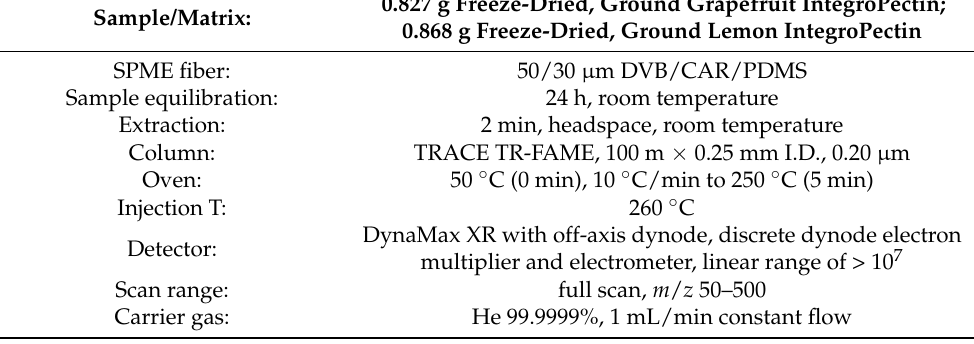
Table 3. Conditions for the analysis.